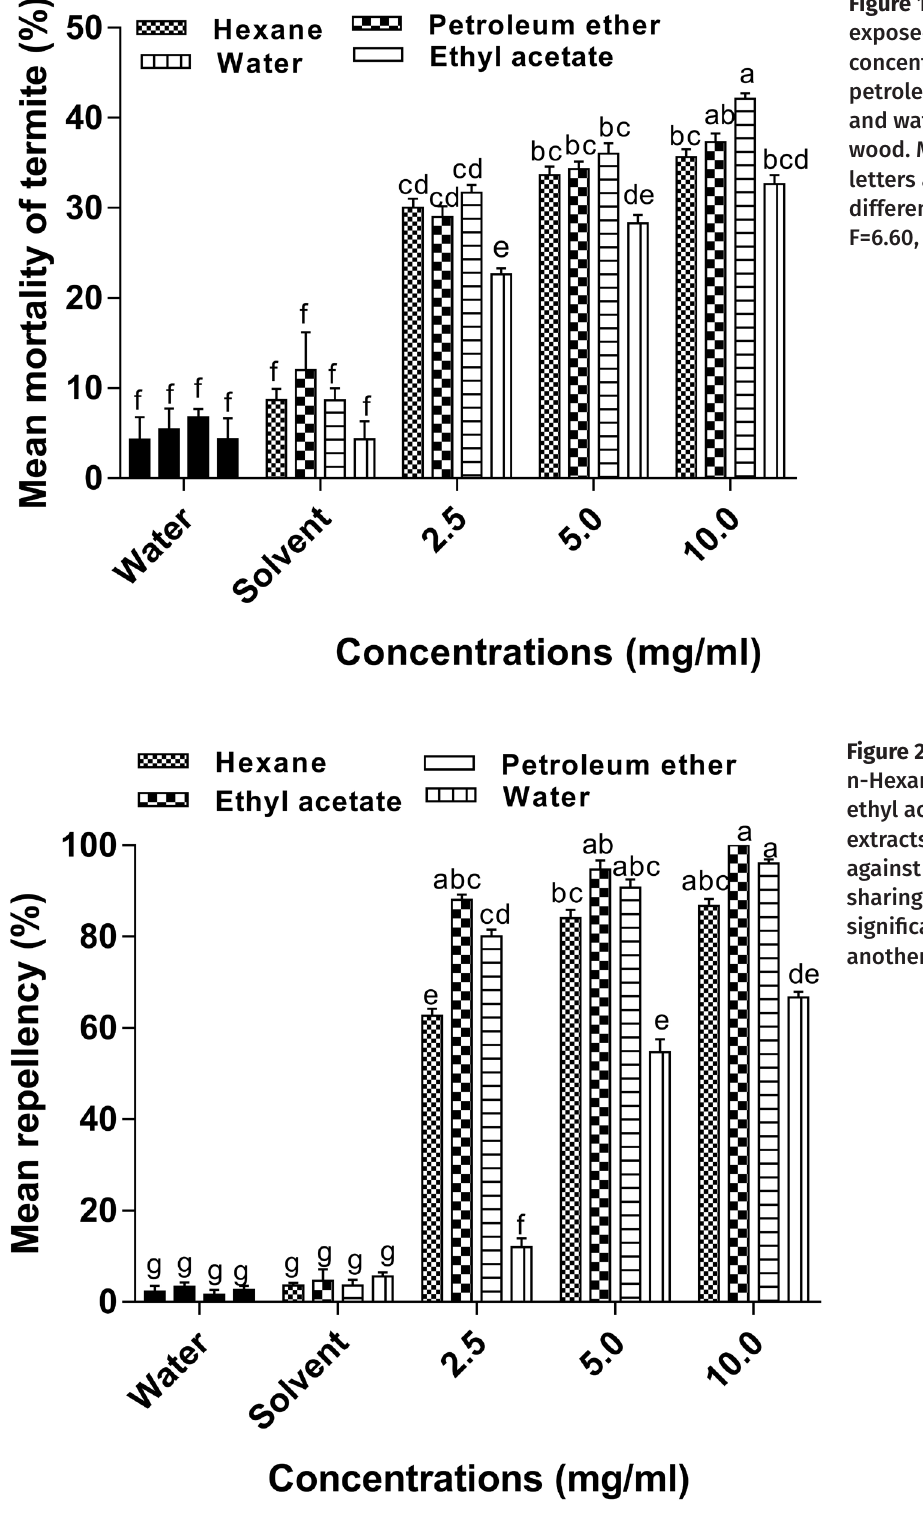
Figure 1. Mortality of termites exposed to different concentrations of n-Hexane, petroleum ether, ethyl acetate, and water extracts of P. pinnata wood. Means sharing different letters are significantly different from one another. F=6.60,